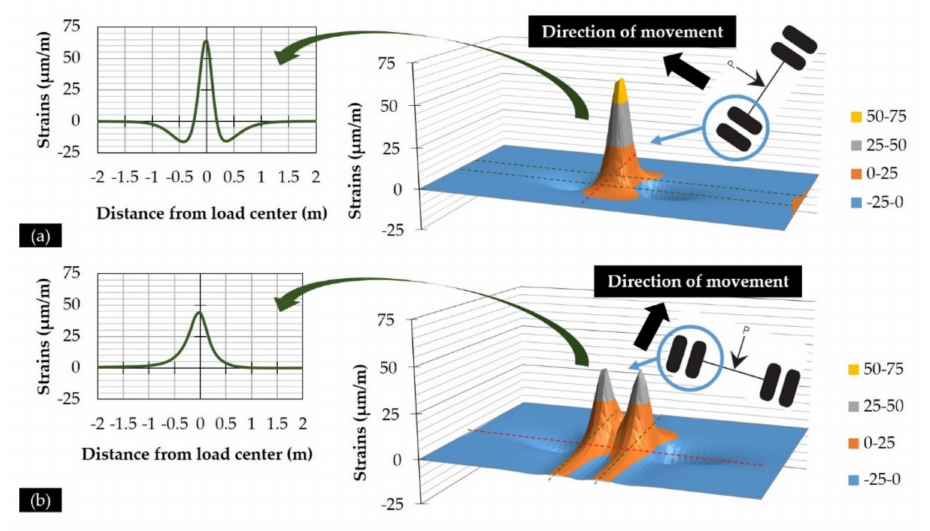
Figure 10. Strain distribution at the bottom of the AC: ( a ) longitudinal and ( b ) transverse strain